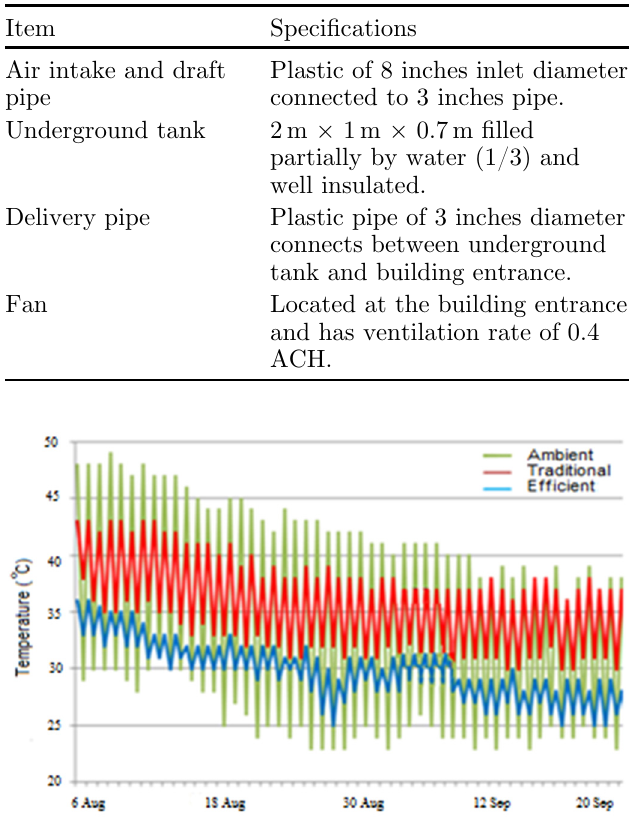
Table 1. Speci fi cations of ventilation system implemen- ted in the current study.